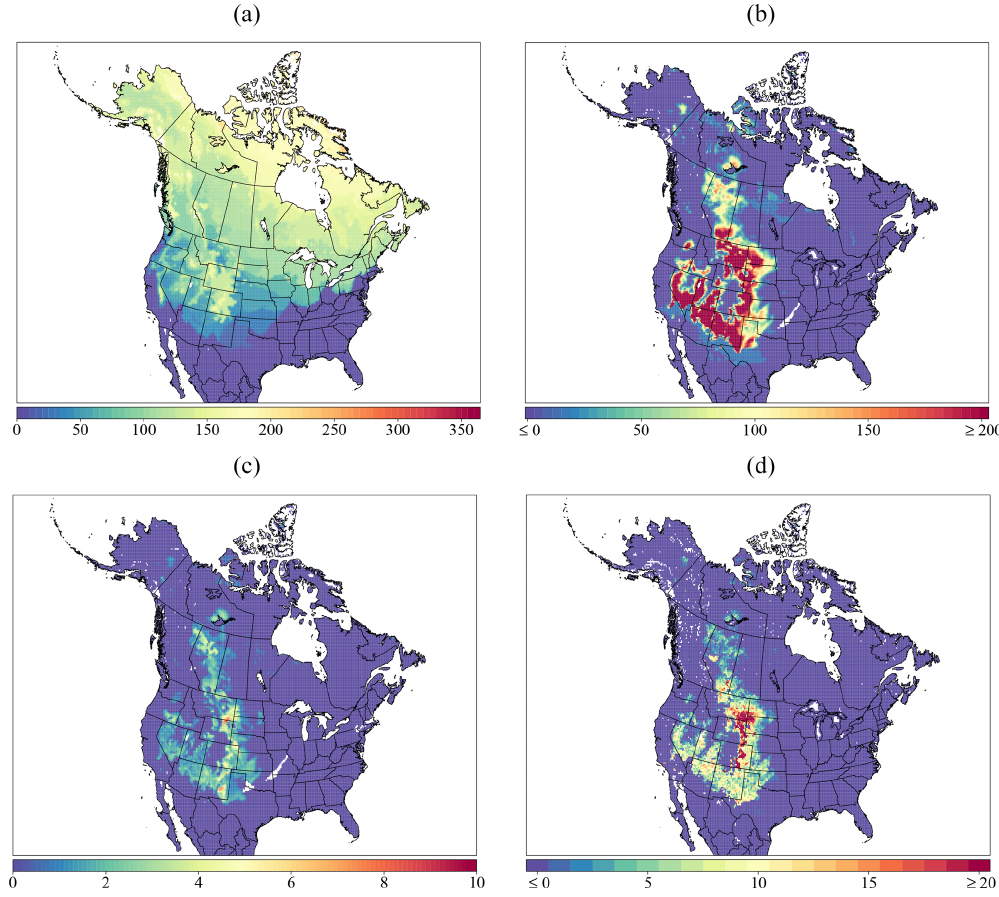
Figure 3. Differences in FWI calculation using the default DC start-up value versus the overwintered DC start-up value for North America in 2016. (a) Start-up day of year for FWI calculation based on longest period satisfying the meteorological fire season condition given by Wotton and Flannigan (1993). (b) The difference between overwintered DC and default DC start-up values (i.e. DC = 15) on the day of year given by (a) . (c) The difference in FWI values corresponding to (b) . (d) The corresponding difference in fire spread days (defined as FWI > 19 as per Podur and Wotton, 2011). Map displayed in Atlas of Canada Lambert conformal projection